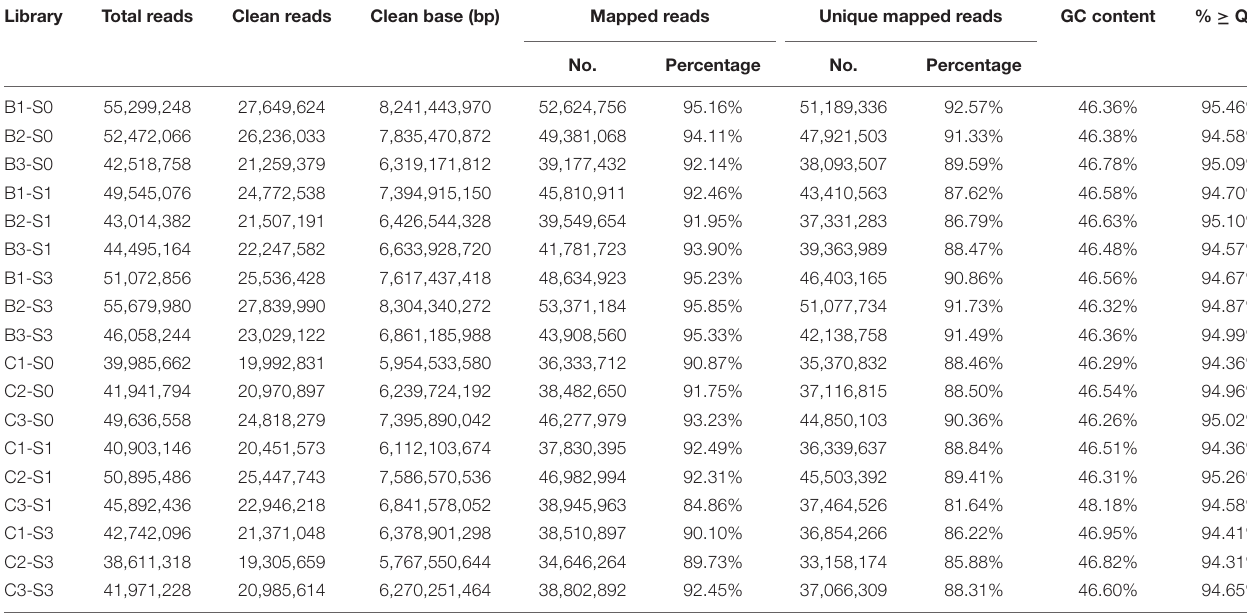
FIGURE 6 | The concentration of ROS in anthers of “ZH” and “JX” throughout their development. (A) Accumulation of H 2 O 2 in anthers at stages 1–5. Error bars indicate standard deviation (SD) of three biological replicates. Statically significant differences at P ≤ 0.01 (Student t -test) is indicated by ∗∗ . (B) Measurement of O 2 − accumulation in anthers at stages 1–5 using NBT staining. The intensity of blue color indicates high content of O 2 − . All bars represent 500 µ m. TABLE 1 | Summary of RNA-seq data for anthers of two peach cultivars at three stages*.